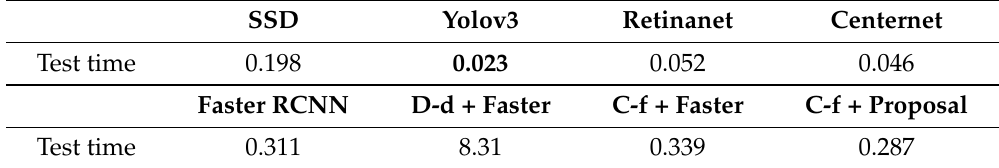
Table 3. Comparison of detection time between the proposed method in this paper and a series of detection algorithms (s/image), where D-d+Faster, C-f+Faster, C-f+Proposal denotes the proposed Discriminant dictionary + Faster, and Correlation filter + Faster, Correlation filter + Proposal methods, respectively.